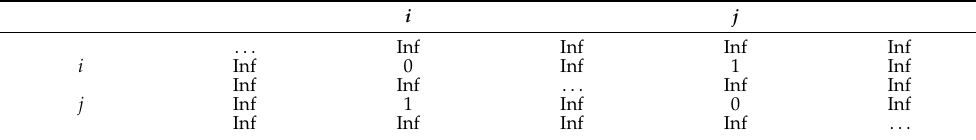
Table 6. The node matrix J .